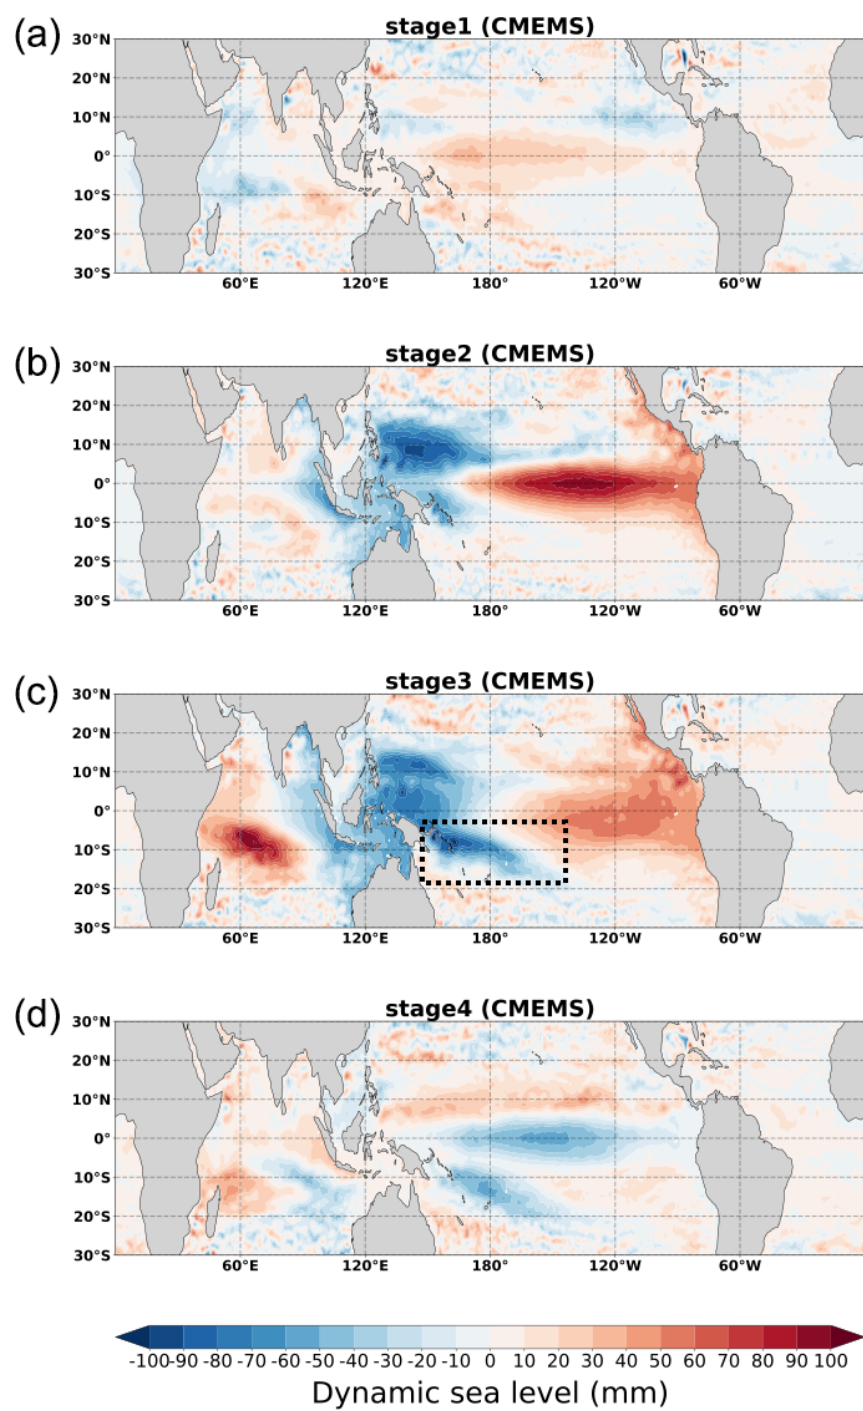
Figure 25. The DSL evolution from satellite altimeter observation in four different stages (top to bottom) during the El Niño composite (1993–2007) defined in Fig. 24. The dashed black box shows the region of asymmetric sea level change in the southwestern tropical Pacific at stage